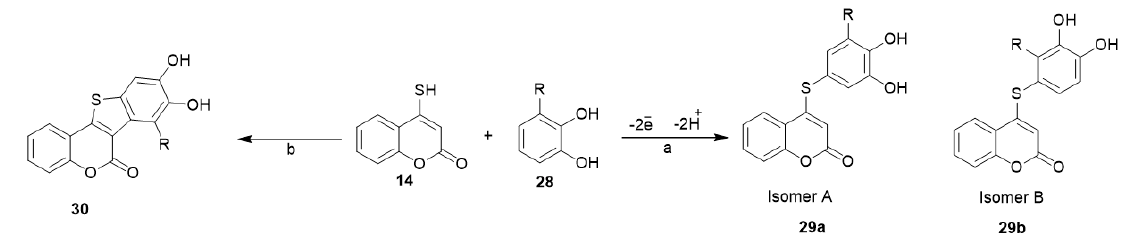
Scheme 12. Synthetic pathways for the reaction of catechol with 4-mercapto-coumarin. Reagents and conditions: ( a ) sodium acetate solution ( c = 0.2 M) in water/acetonitrile (50/50), undivided